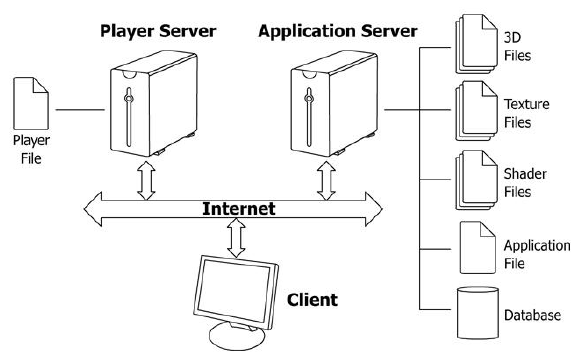
Figure 11. On-line application architecture.